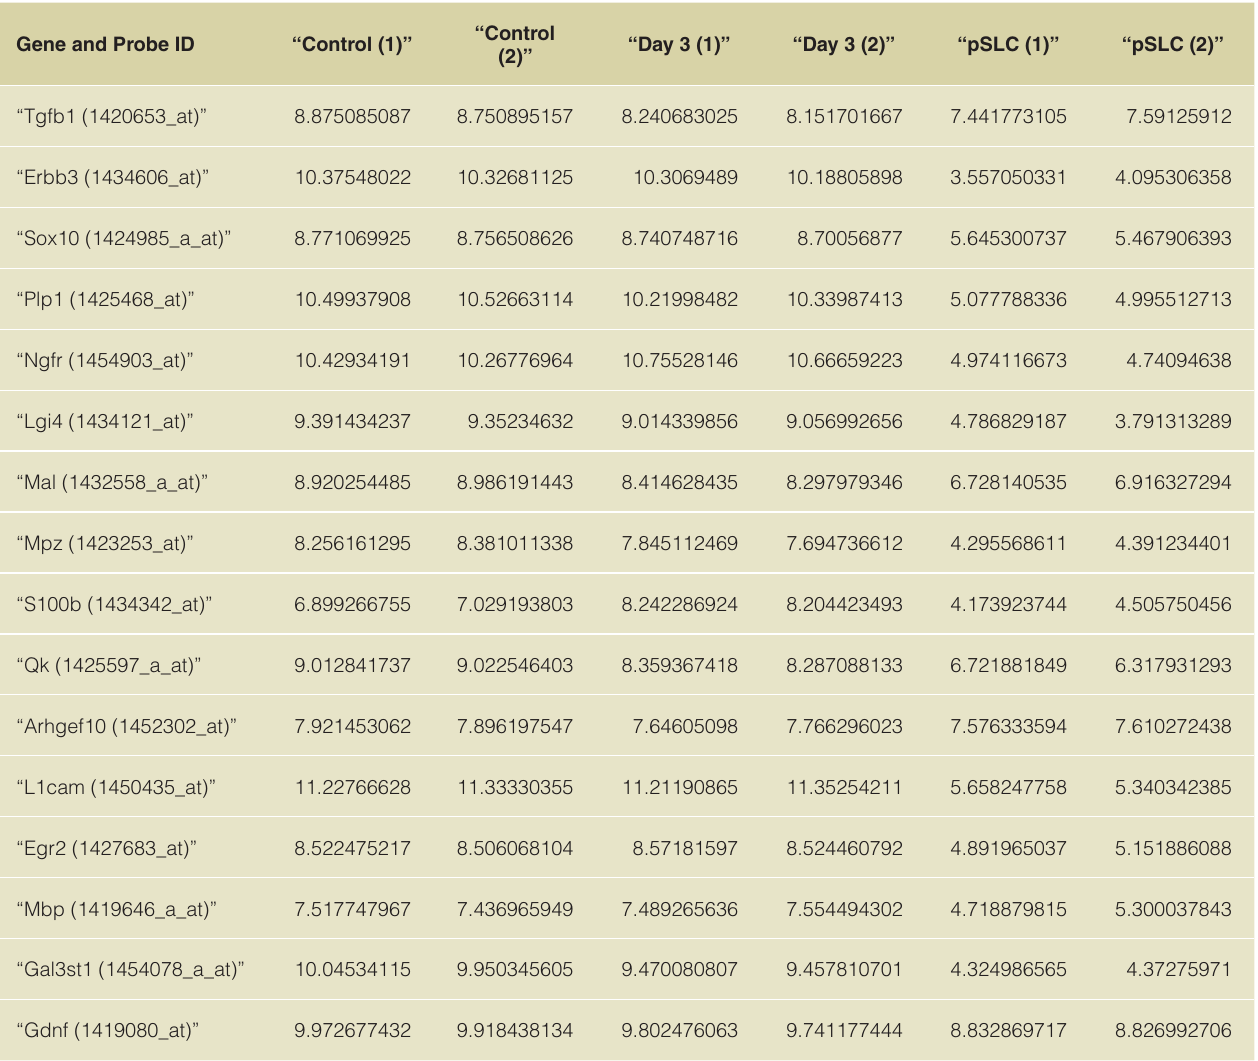
Table S1. Microarray data for Figure 1C. Robust Multichip Average (RMA) values for selected Schwann cell lineage markers, representing absolute gene expression as calculated across 6 microarrays, from 2 samples (S1 and S2) each from control/uninfected Schwann